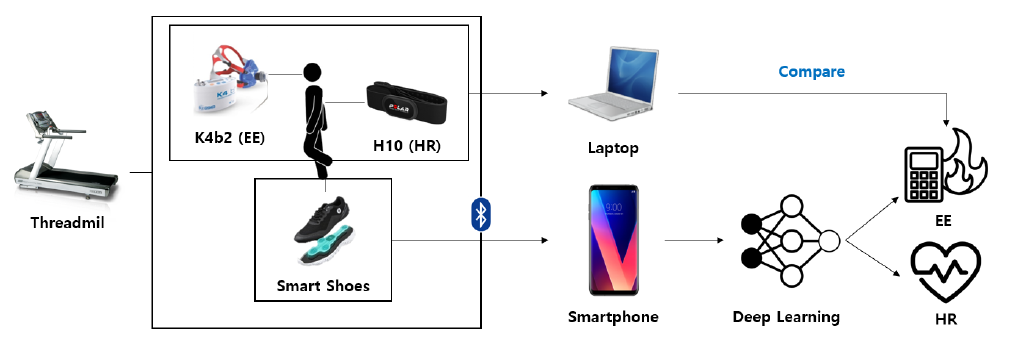
Figure 1. Overview of the system architecture for EE and HR